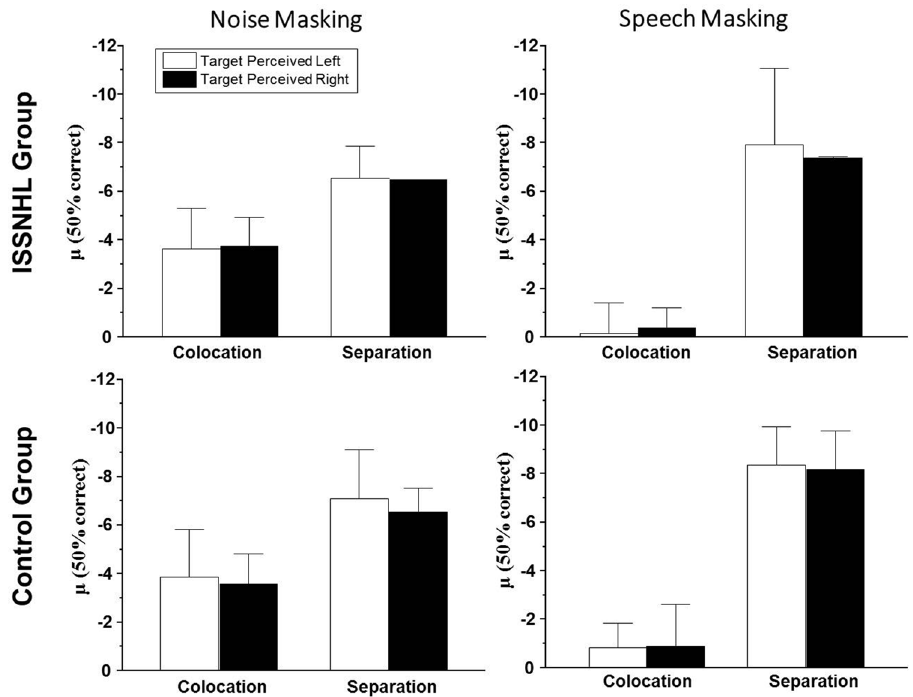
Figure 1. Participants’ SIN perception threshold μ when targets were perceived from left to the threshold when targets were perceived from right.